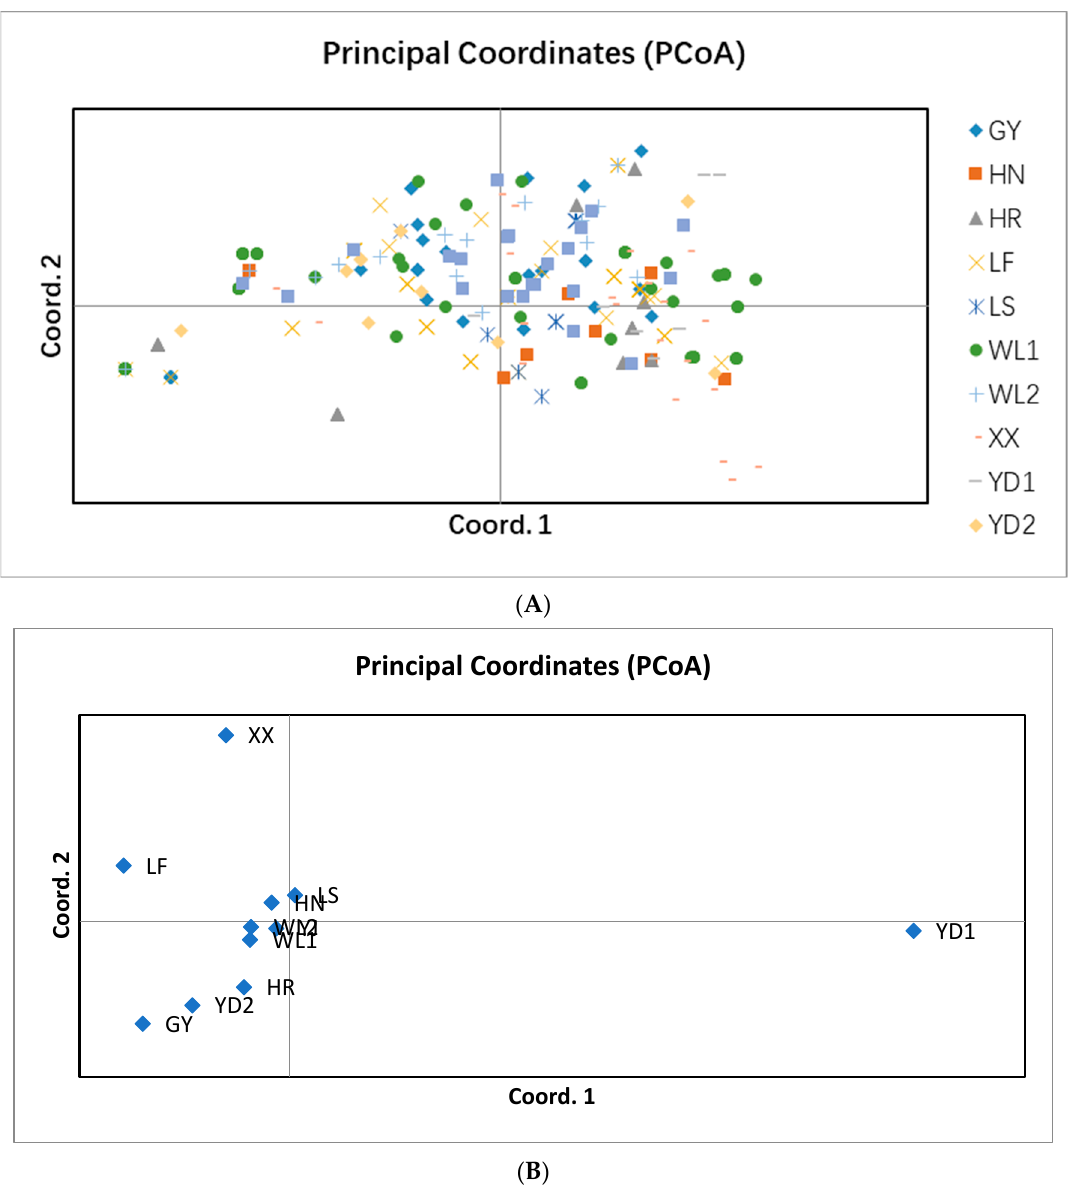
Figure 4. Principal coordinate analysis (PCoA) of the genetic variation among strains and populations of F. commune analyzed in this study. ( A ): PCoA based on 354 strains; ( B ): PCoA based on 11 local geographic populations.